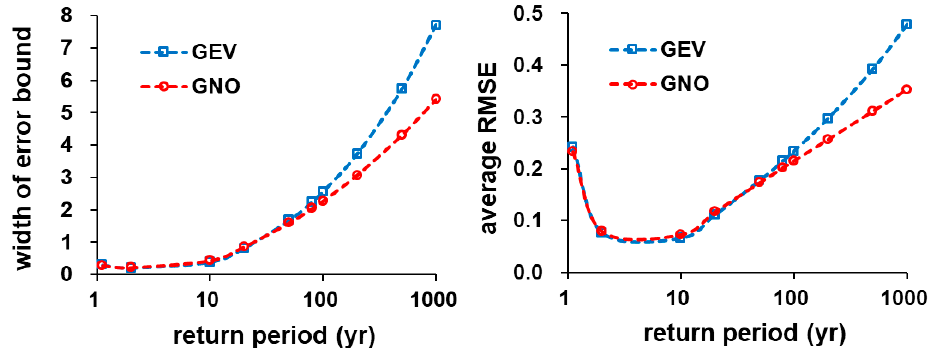
Figure 5. Width of error bounds and regional average relative RMSE of the estimated growth curves. width of error bounds (left); regional average relative RMSE (right).